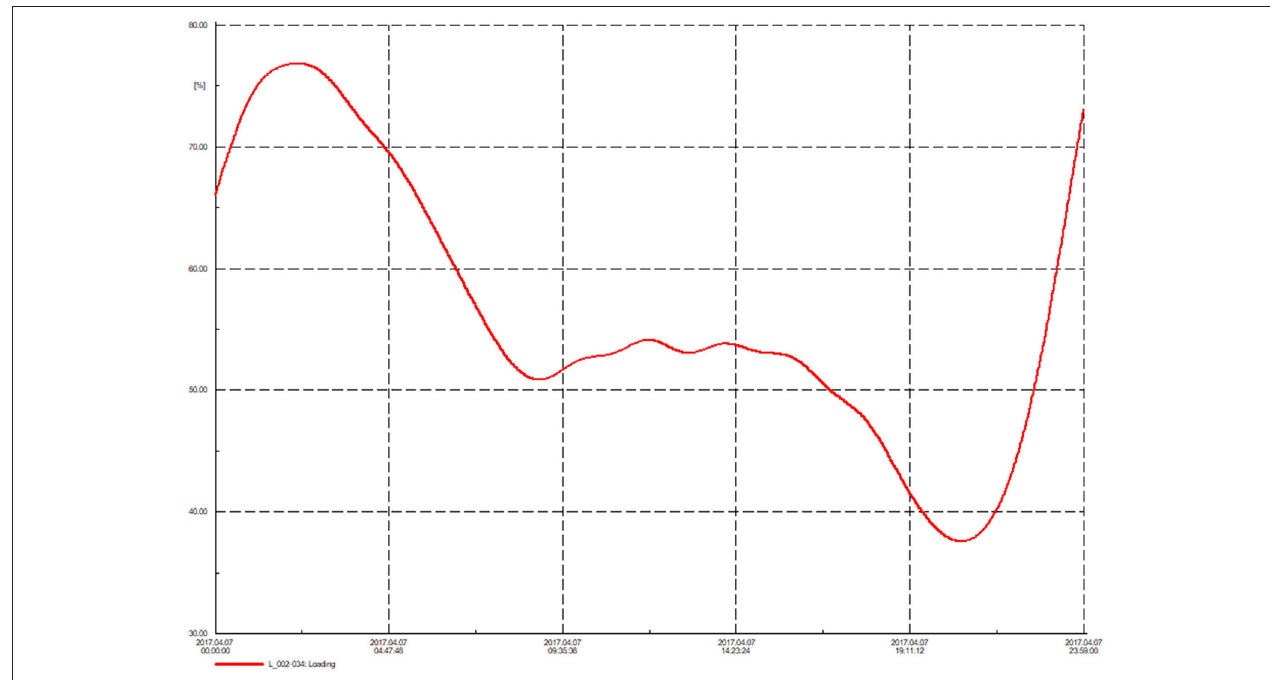
FIGURE 11 | Test case 2—with DIgSILENT.